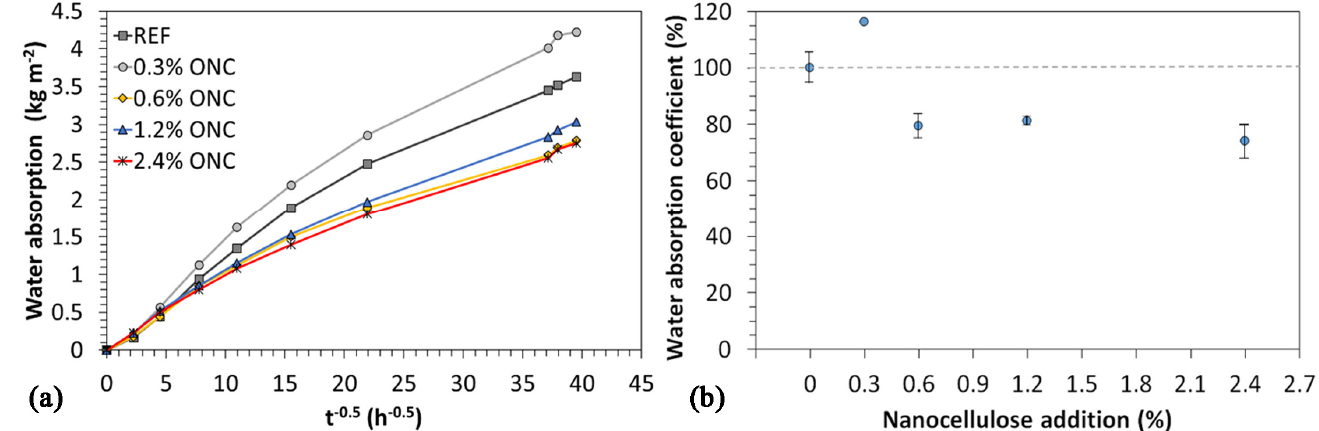
Figure 10. Measured water absorption trends vs. time of mortars with different ONC content (average profiles over three samples per type).